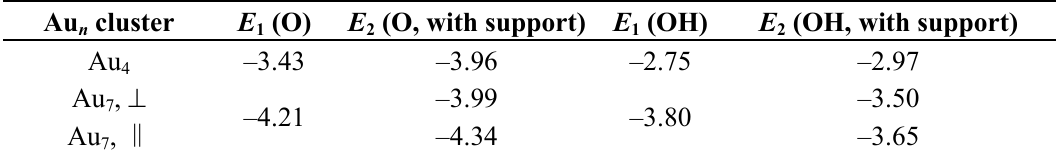
Table 4. Calculated adsorption energies of O and OH on Au without N-graphene